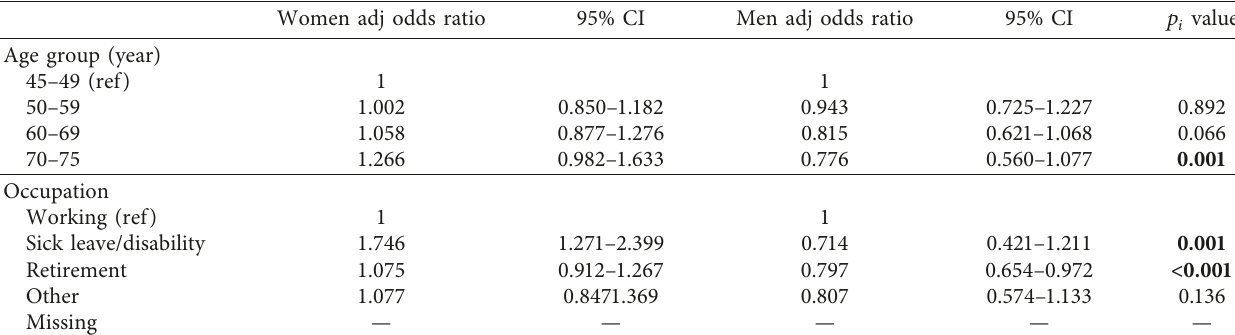
Table 5: Associations between normal-weight obesity versus overweight and sociodemographic factors in relation to sex in the EpiHealth